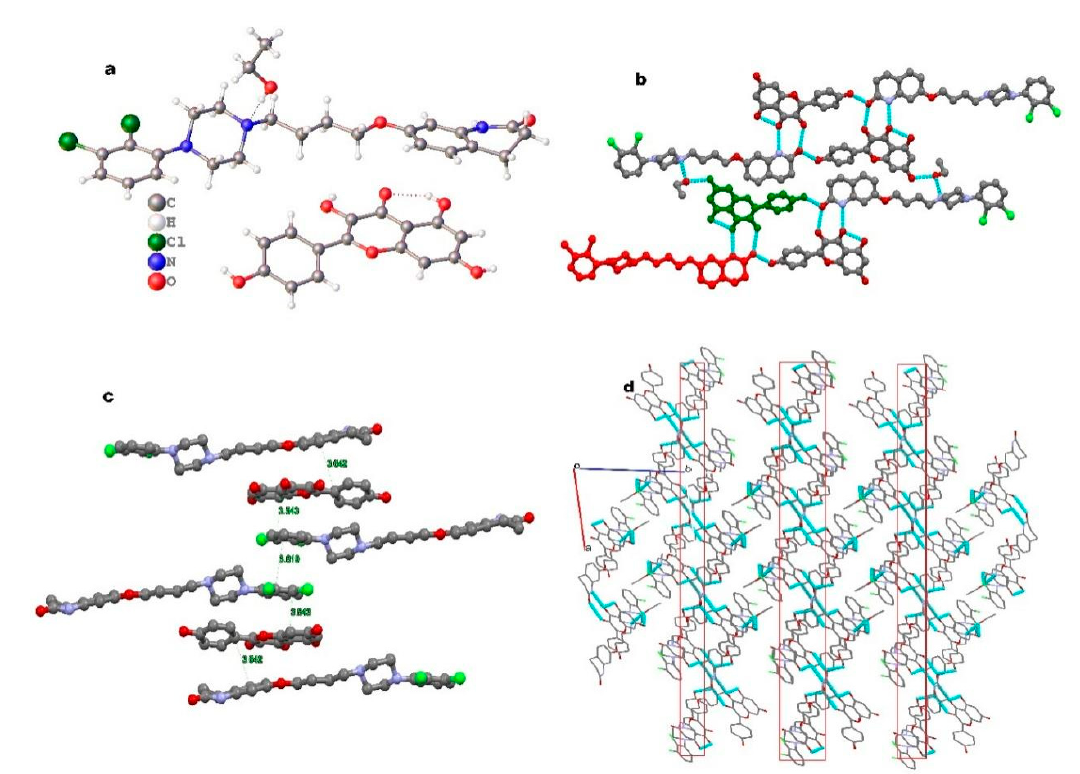
Figure 3. ( a ) The asymmetric unit for ARI-KAE·EtOH, ( b ) hydrogen bonds, ( c ) π - π interaction, ( d ) 2D sheet along [011]. ARI-KAE·IPA crystal structure also belongs to P-1 space group; the asymmetric unit contains an aripiprazole molecule, a kaempferol molecule and an isopropanol molecule, as shown in Figure 4a. Kaempferol and aripiprazole form a dimer through N3-H3 ⋯ O6 and O7-H7 ⋯ O2 hydrogen bonds, and the dimers forms a tetramer through O8-H8 ⋯ O2 hydrogen bonds. The tetramers were connected by two isopropanol molecules through O9-H9 ⋯ N2 and O3-H3A ⋯ O9 hydrogen bonds, forming a 1D hydrogen bond chain along the [111] direction (Figure 4b). The 1D hydrogen bond chain packing together through π -